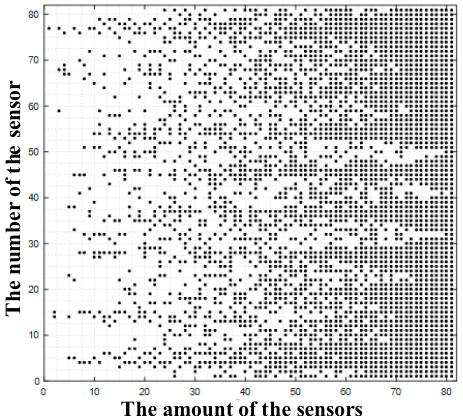
Figure A2. Optimal placement of the structure under different numbers of sensors.